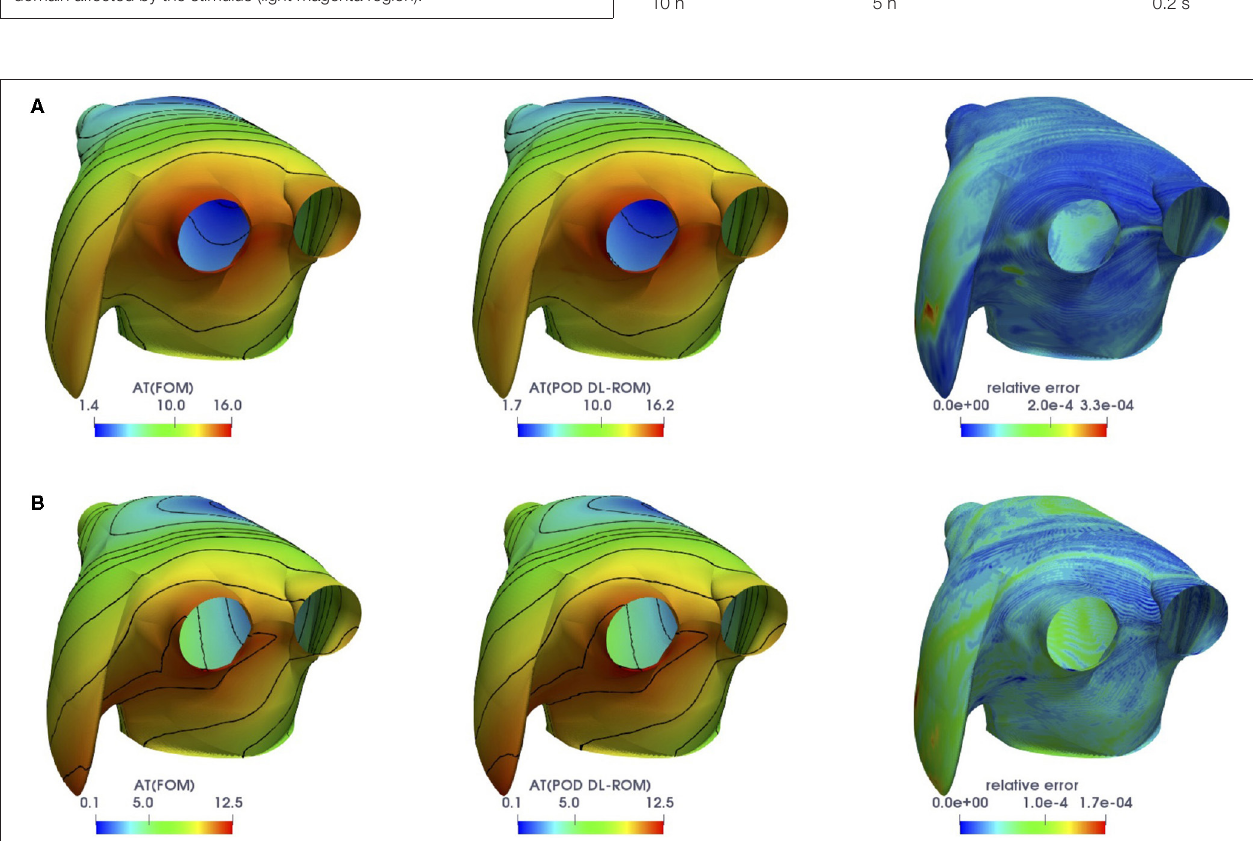
FIGURE 7 | Test 2 : Parameter space (dark magenta region) and portion of domain affected by the stimulus (light magenta region).